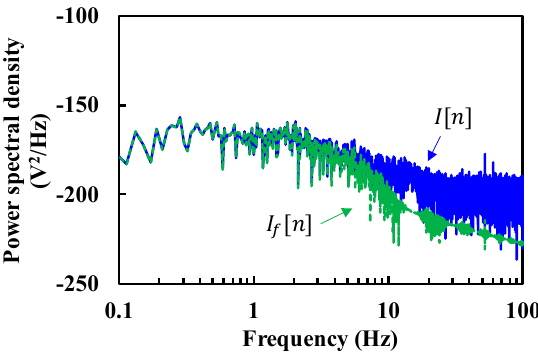
Figure 4. Power spectral density of I signal before and after LPF1 ( I [ n ] and I f [ n ] , respectively).